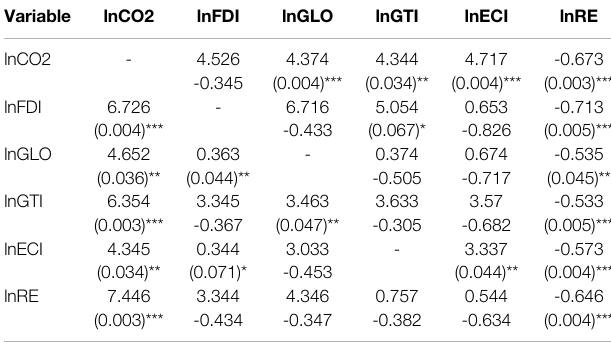
TABLE 8 | Pairwise Granger causality tests